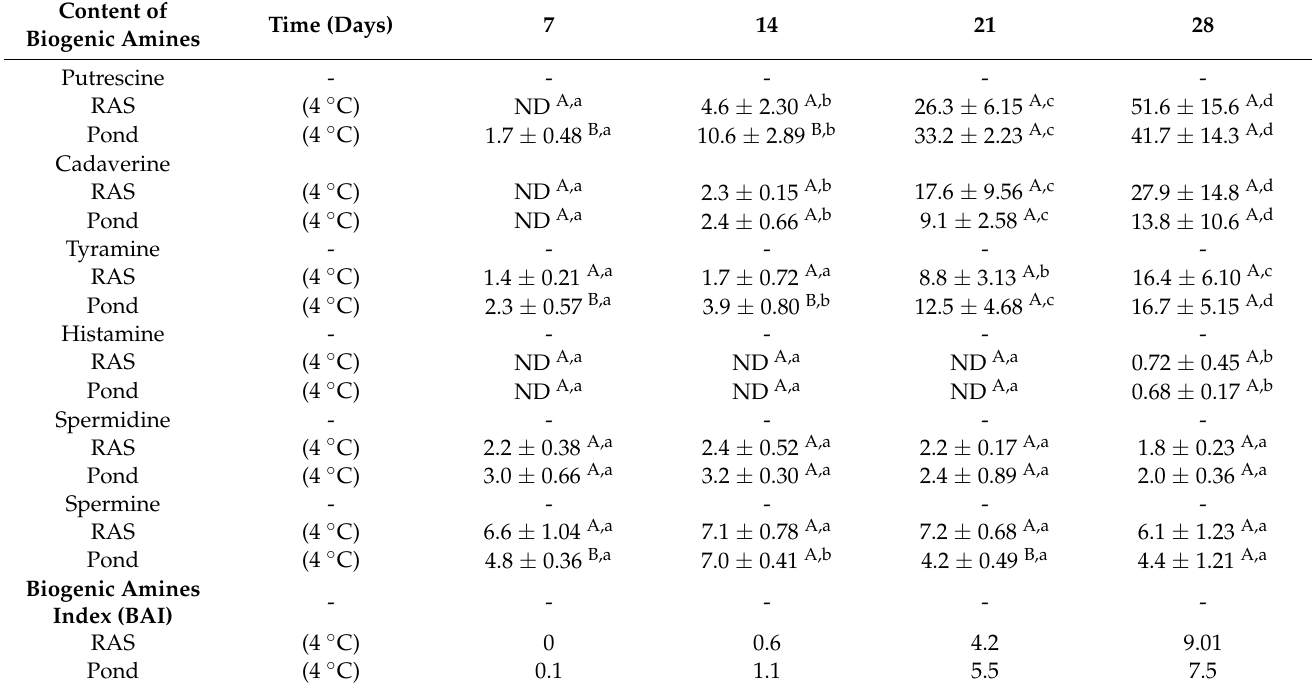
Figure 2. pH of perch from RAS and pond during 140 h refrigerated storage at +4 ◦ . Different capital letters on the lines donate significant differences ( p < 0.05) in each rearing system. Small letters on the lines donate significant differences ( p < 0.05) between rearing systems at the similar time point (mean ± S.D., n = 6). Table 2. Content of biogenic amines (mg/kg) in fillets of Eurasian perch from RAS and pond rearing systems (mean ± SD; n = 5) stored at +4 ◦